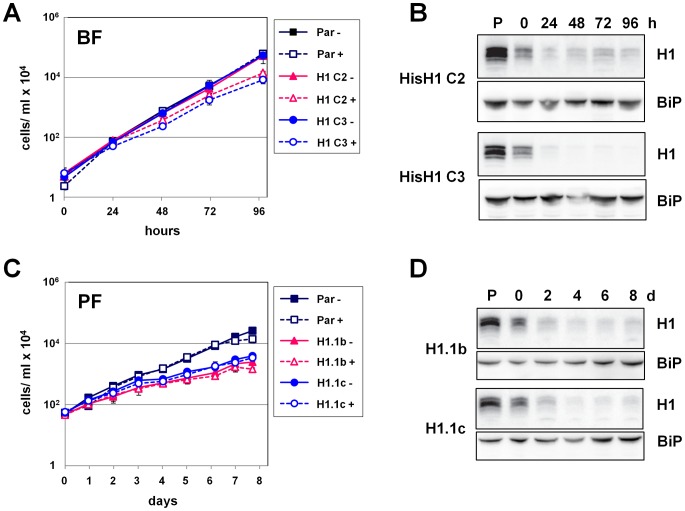
RNAi-mediated depletion of histone H1 proteins results in a moderate reduction in growth rates.
A. Growth curves of parental BF T. brucei or two independent BF T. brucei RYT3-H1 clones in the presence (+) or absence (−) of tetracycline to induce histone H1 RNAi. The mean of three experiments is shown with the standard deviation indicated with error bars. In each case, the cell number was multiplied by the dilution factor to obtain a value for cumulative cell growth. B. Western blot analysis of Tris-tricine gels showing knockdown of histone H1 in two independent BF T. brucei RYT3-H1 histone H1 RNAi clones compared with the parental (P) cell line. Histone H1 RNAi was induced with tetracycline for the time indicated in hours (h). BiP is shown as a loading control. C. Experiment similar to as shown in panel A. performed in PF T. brucei cells. D. A similar experiment as shown in panel B. performed using PF T. brucei cells. Histone H1 RNAi was induced with tetracycline for the time indicated in days (d).